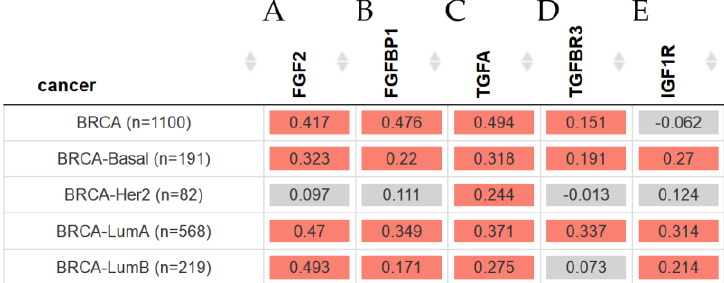
Figure 4. The heatmap table shows the correlation between EGFR expression and ( A ) FGF2 , ( B ) FGFBP1, ( C ) TGFA , ( D ) TGFBR3 , and ( E ) IGF1R gene expression level in breast invasive carcinoma subtypes with purity adjustment. The red color indicates a statistically significant positive correlation (Spearman’s, p < 0.05), and gray denotes a nonsignificant result. The expression level was estimated by TIMER2.0 [19] .